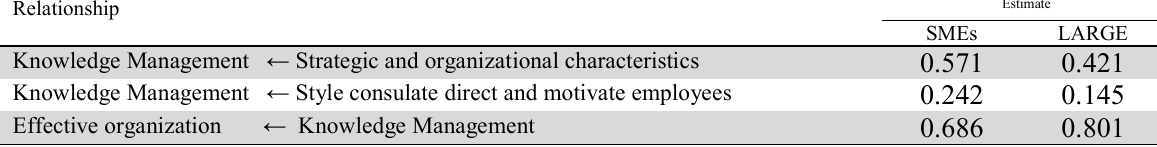
The importance of standardization in the model variability